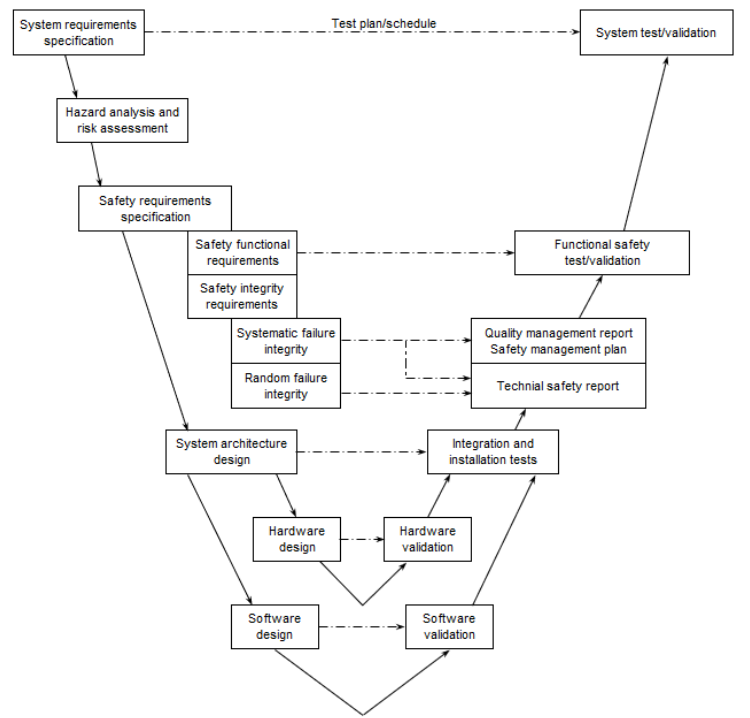
Figure 1. Example of design and validation portion of system life-cycle (EN